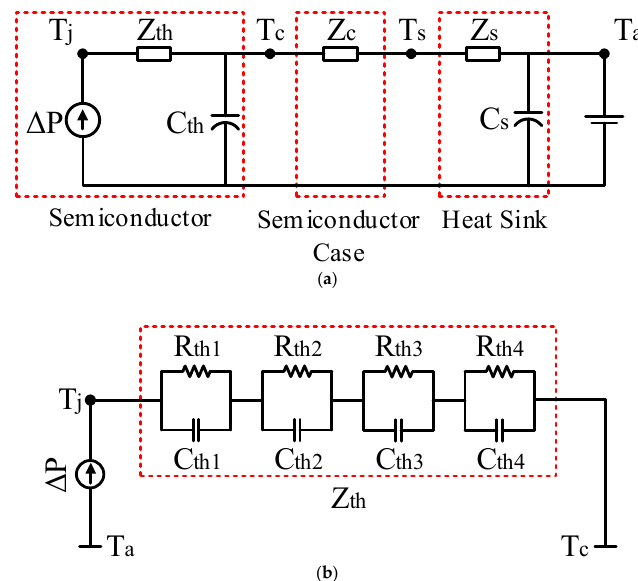
Figure 5. ( a ) Semiconductor thermal model; ( b ) foster network of Z th .